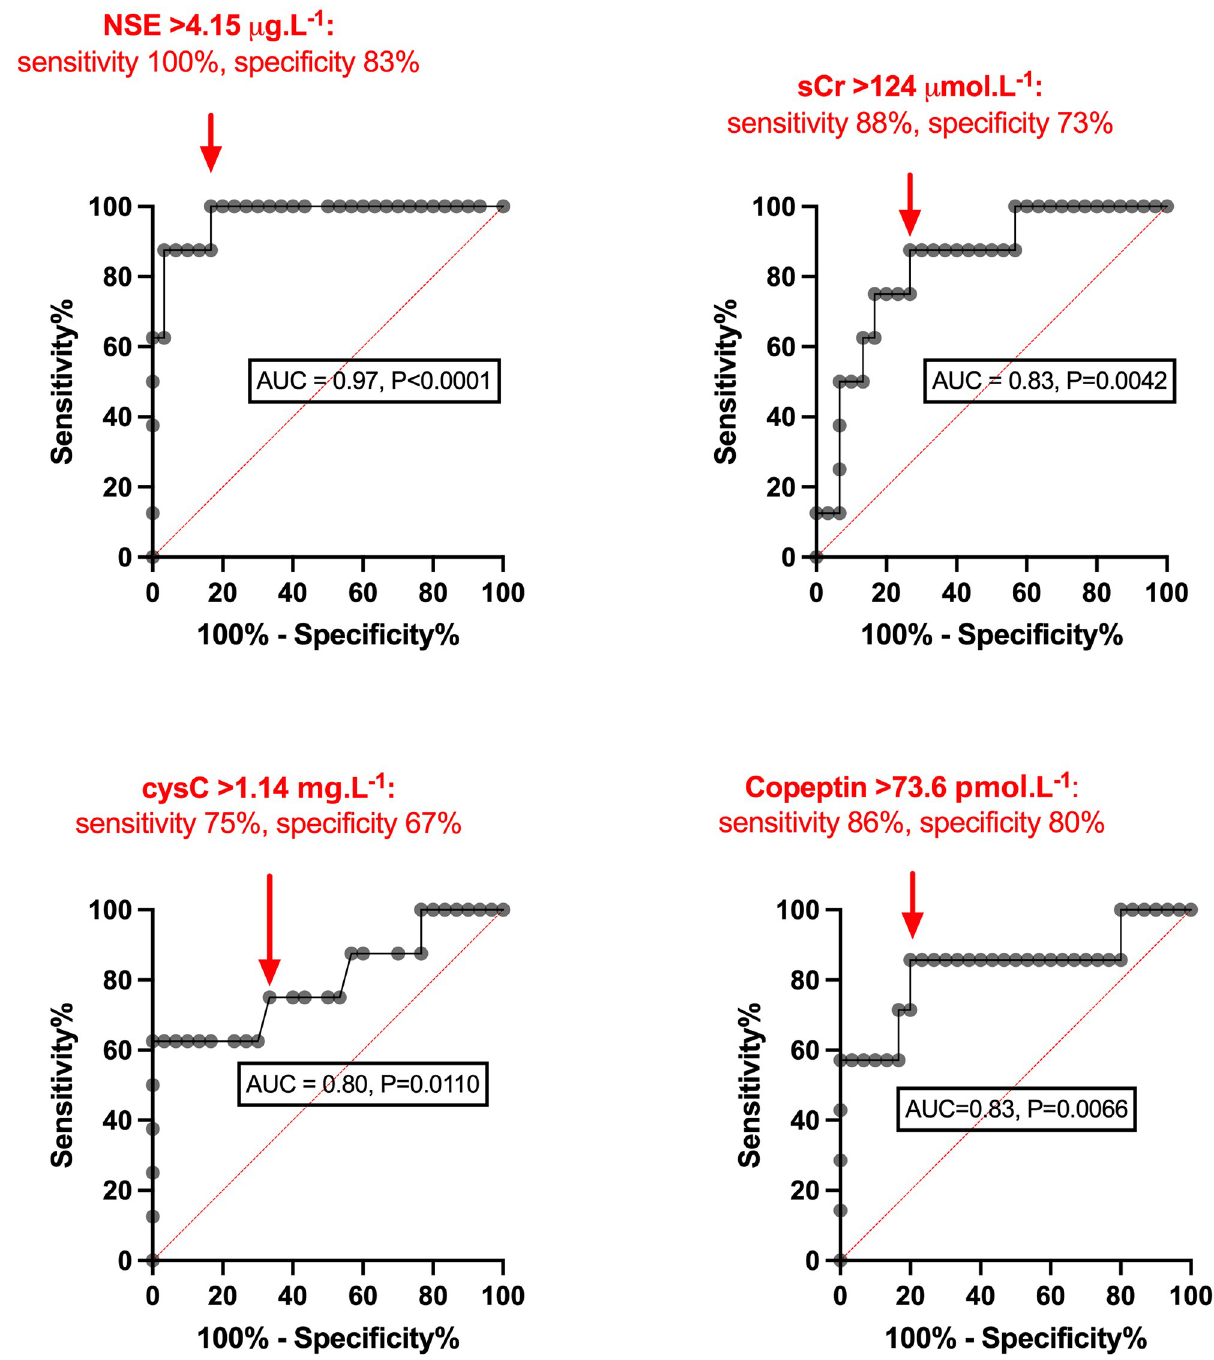
Fig 3. ROC curves for biochemical parameters showing Area-Under-Curve (AUC) � 0.7 for 30 successful finishers (SF) vs 8 Exertional Heat Illness cases (EHI), � assayed at T0 (marathon completion or withdrawal). CysC–cystatin C; NGAL–neutrophil gelatinase associated lipocalin; NSE– neuron specific enolase; sCr–serum creatinine . � n = 7 for copeptin.